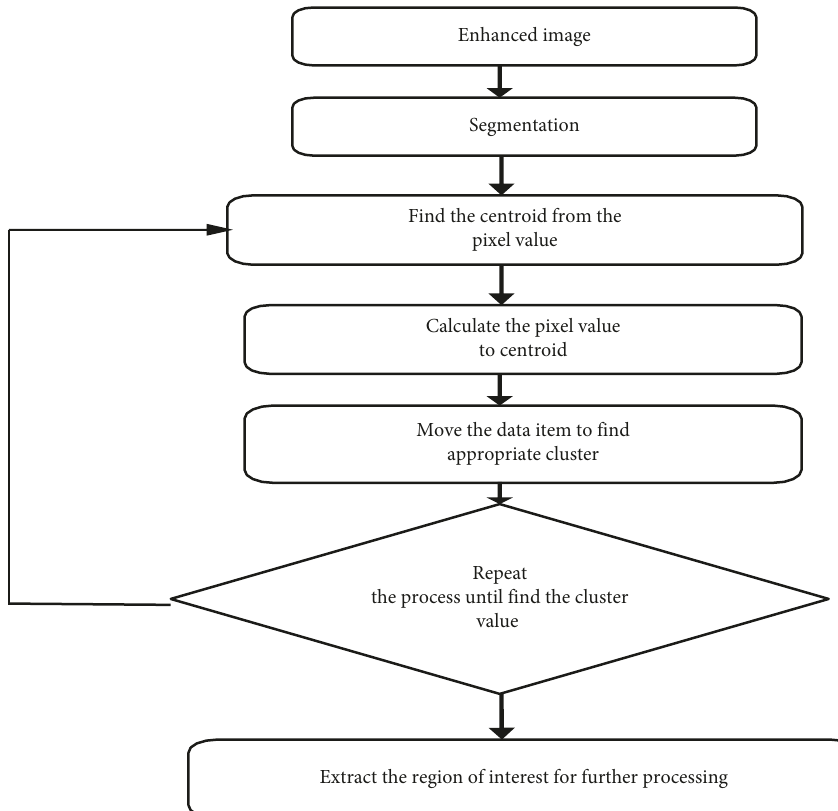
Figure 12: Flow diagram for the image segmentation